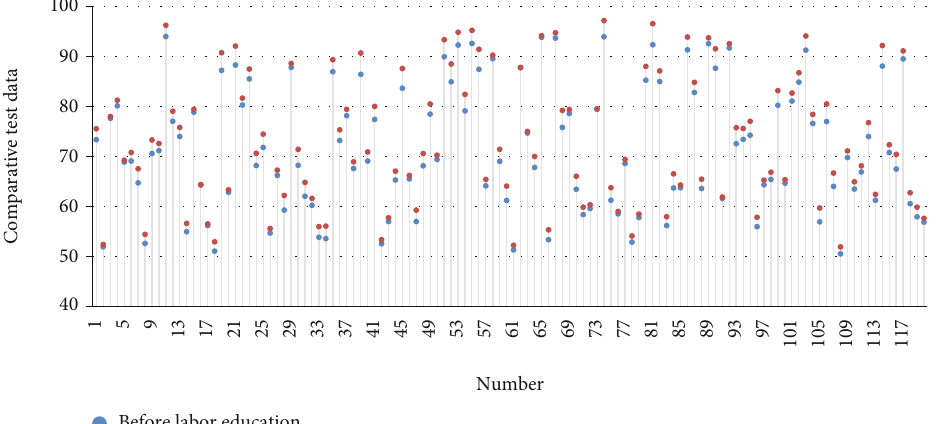
Figure 6: Comparison of learning enthusiasm.